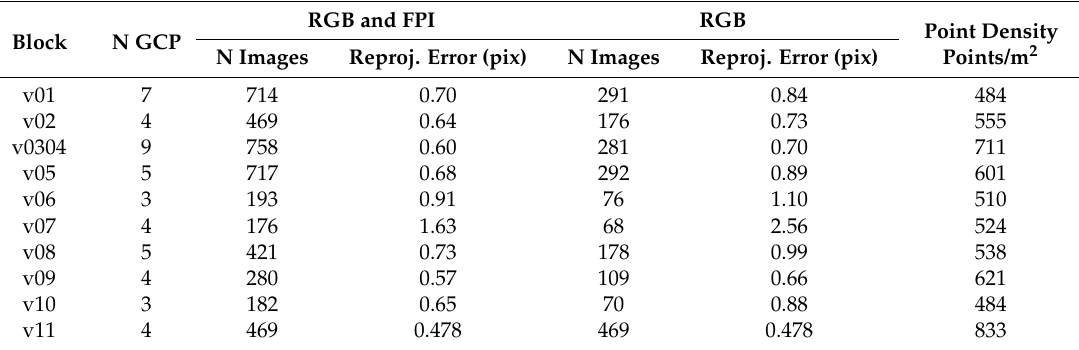
Table 8. Results of orientation processing: numbers of images (N images), reprojection errors, and point density in points/m 2